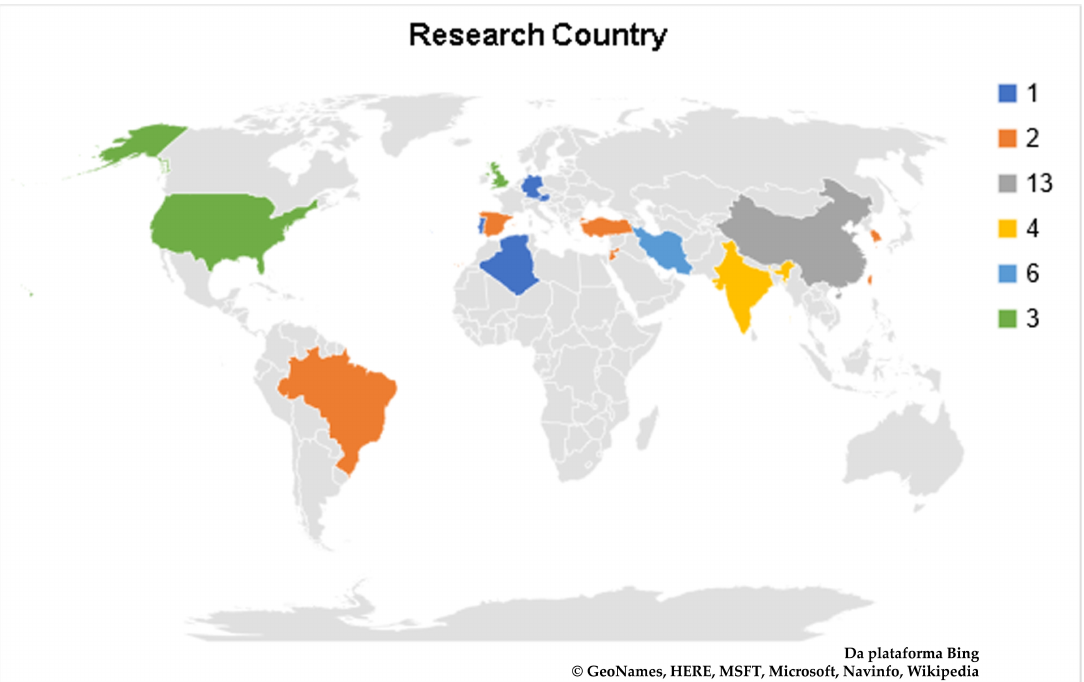
Figure 6. Overview of the research countries from the selected articles.